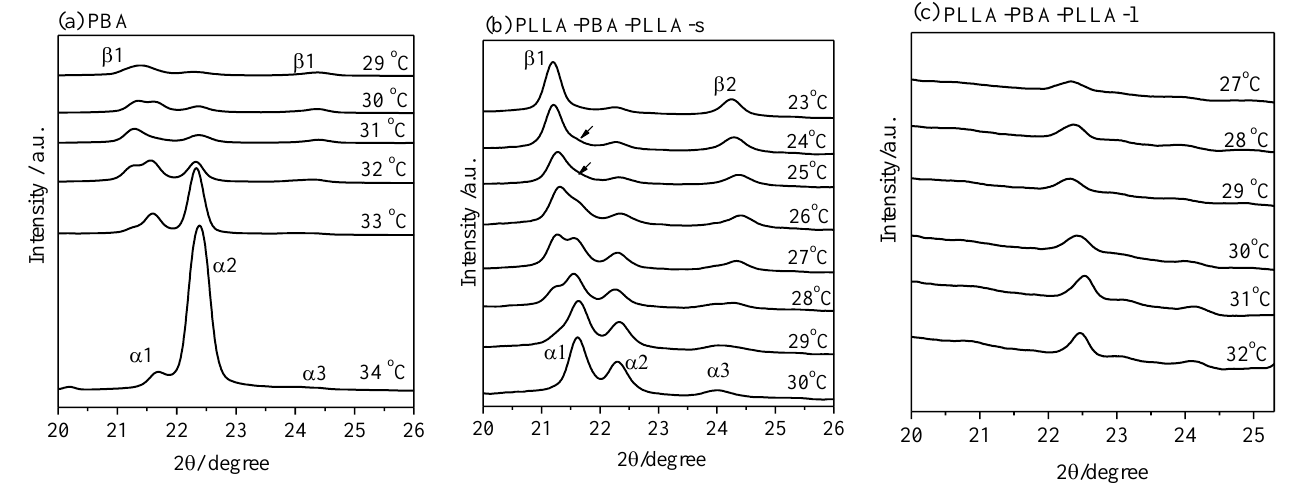
Figure 5. WAXD patterns of ( a ) PBA, ( b ) PLLA-PBA-PLLA-s, and ( c ) PLLA-PBA-PLLA-l after melt crystallization at different temperatures under the thermal program 2.